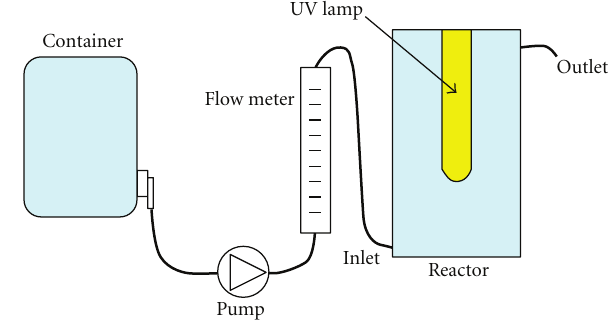
Figure 1: Diagram of the experimental